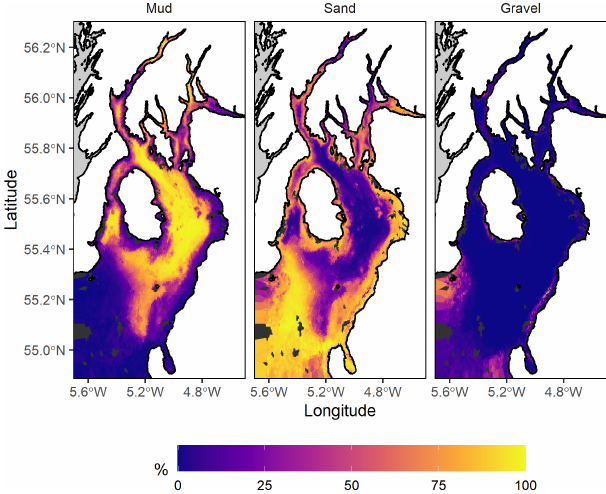
Figure 7. Mapped percentages of mud, sand, and gravel within Firth of Clyde sediments predicted from random forest